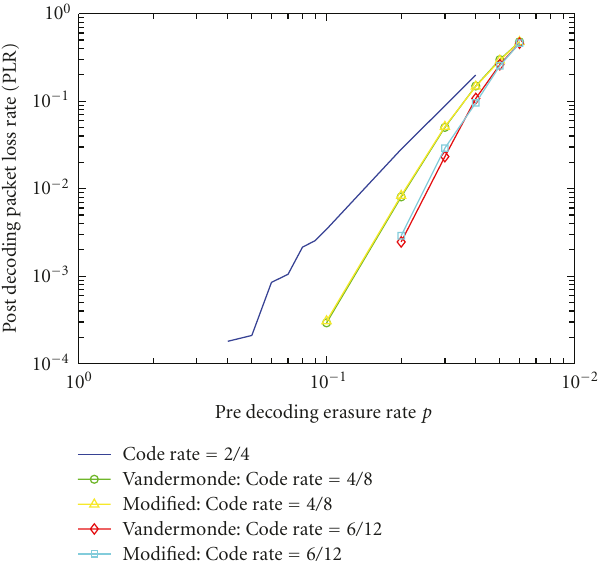
Figure 3: Packet loss rate for systematic codes with the same code rate of 1/2 but di ff erent d min .